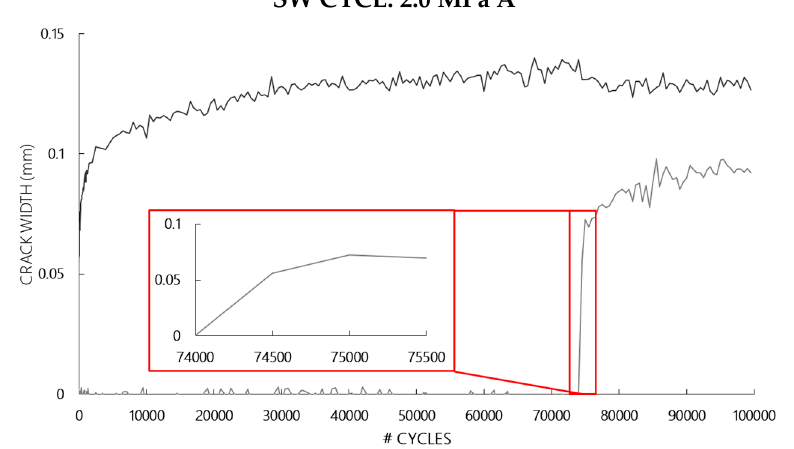
Figure 16. Evolution of the crack width of some representative cracks formed during cyclic loading of sandwich